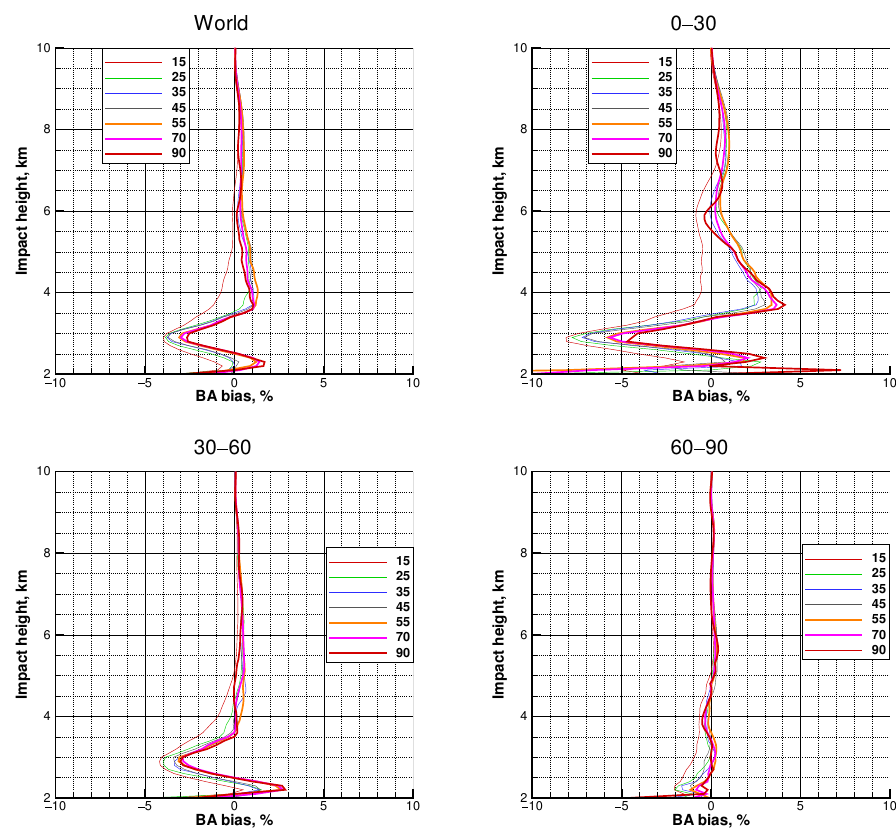
Figure 11. Similar to Figure 2. METOP-B, systematic difference, dynamic